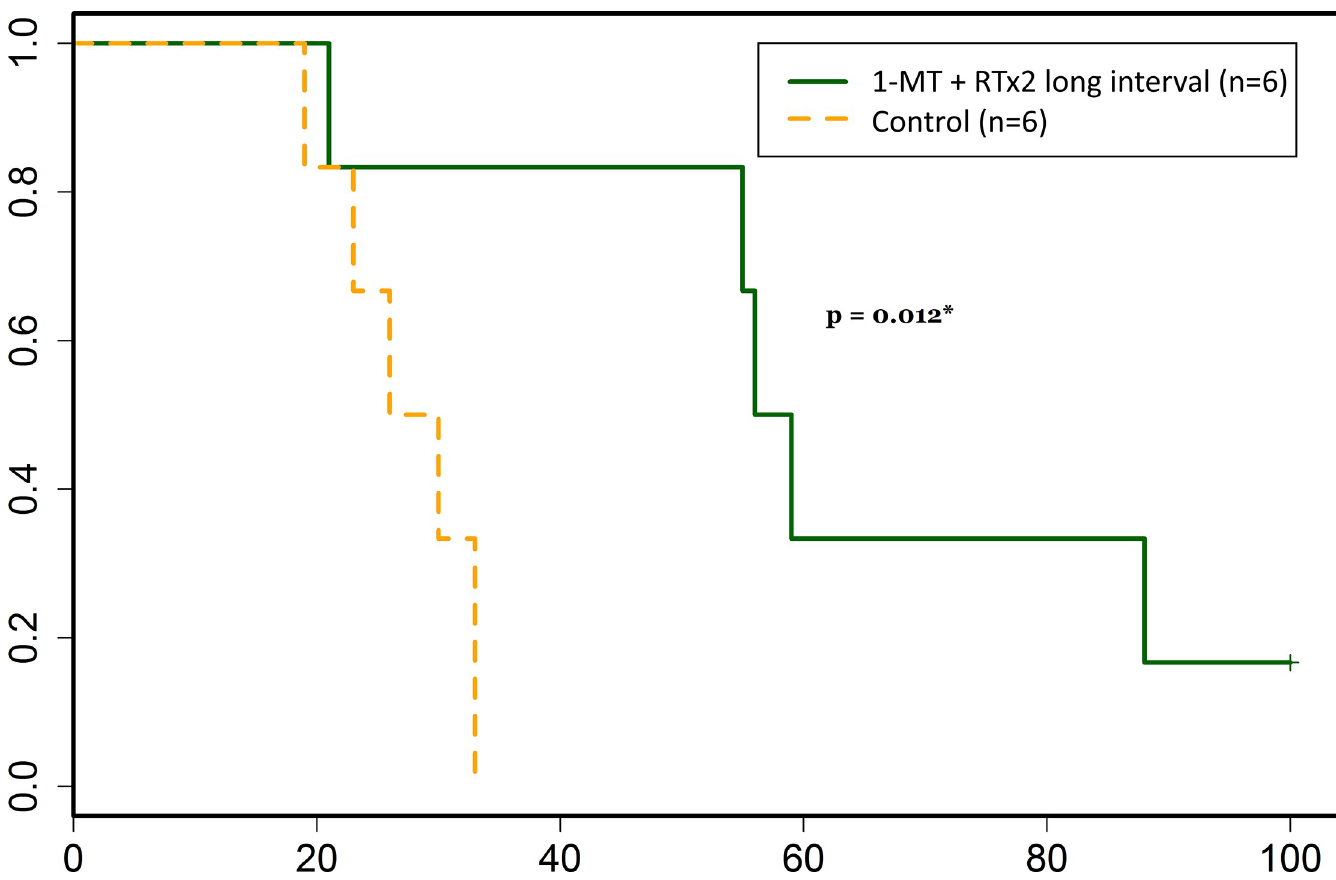
Fig 7. Survival was significantly increased in animals treated with 1-MT + RT x 2 (7 days between the two fractions) as compared to control animals (p = 0.012), which is demonstrated in the Kaplan-Meier curve presented here. Survival in days after tumor cell inoculation is represented on the x-axis, and the proportion of animals still alive is represented on the